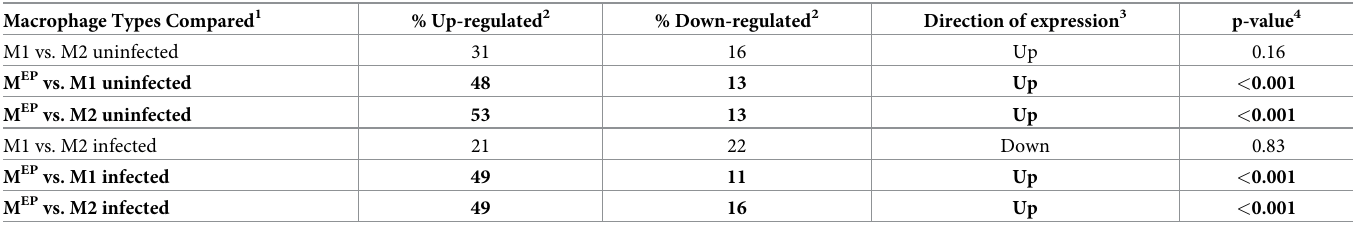
Table 1. Roast gene-set enrichment test for the endotoxin tolerance signature. Macrophage Types Compared